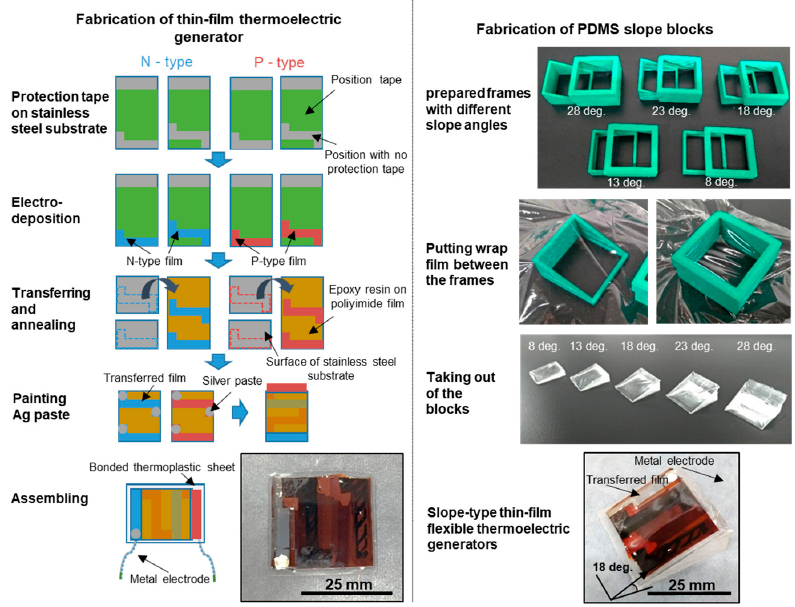
Figure 1. Schematic process flow diagram of the fabrication of slope-type thermoelectric generators.